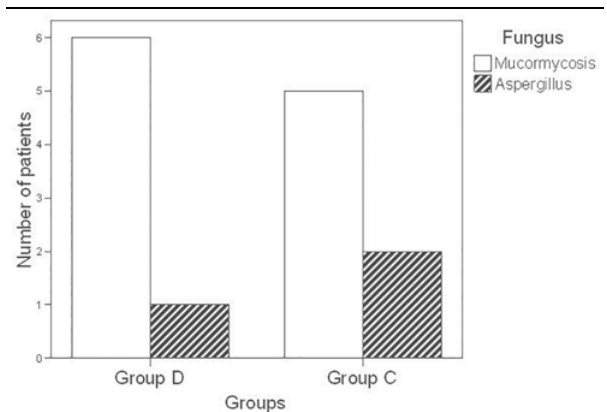
Bar chart for sinus involvement among groups. * P < 0.05, signi (cid:383) cant difference between groups. Group D = L -alanyl- L -glutamine group; group C = control group .